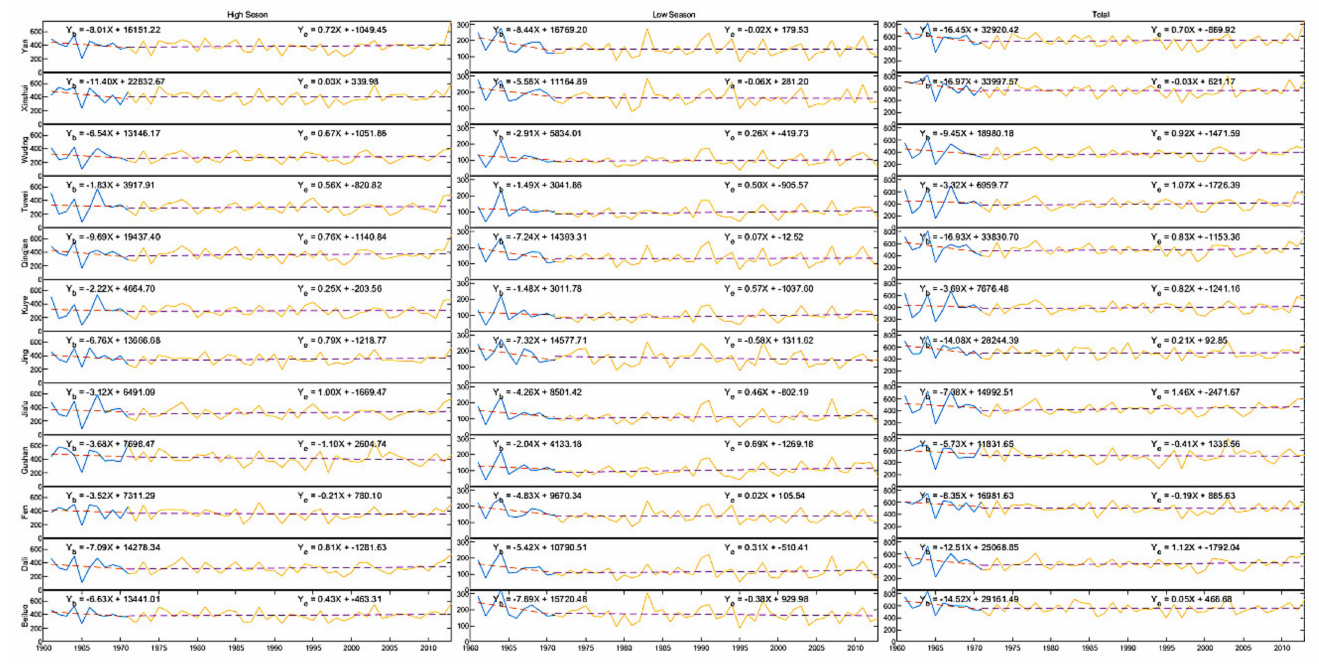
Figure A2. Time series of precipitation change for 12 catchments at intra- and inter-annual scales.